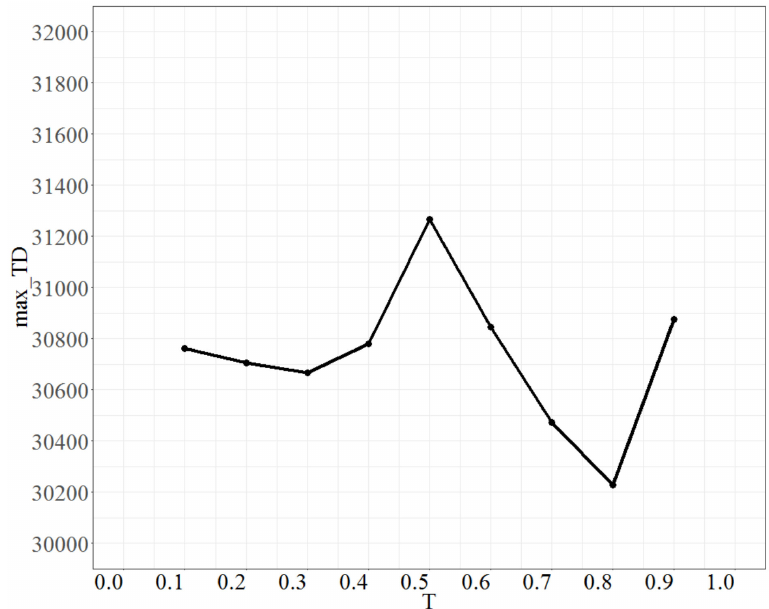
Figure 7. Plot of max_TD as T